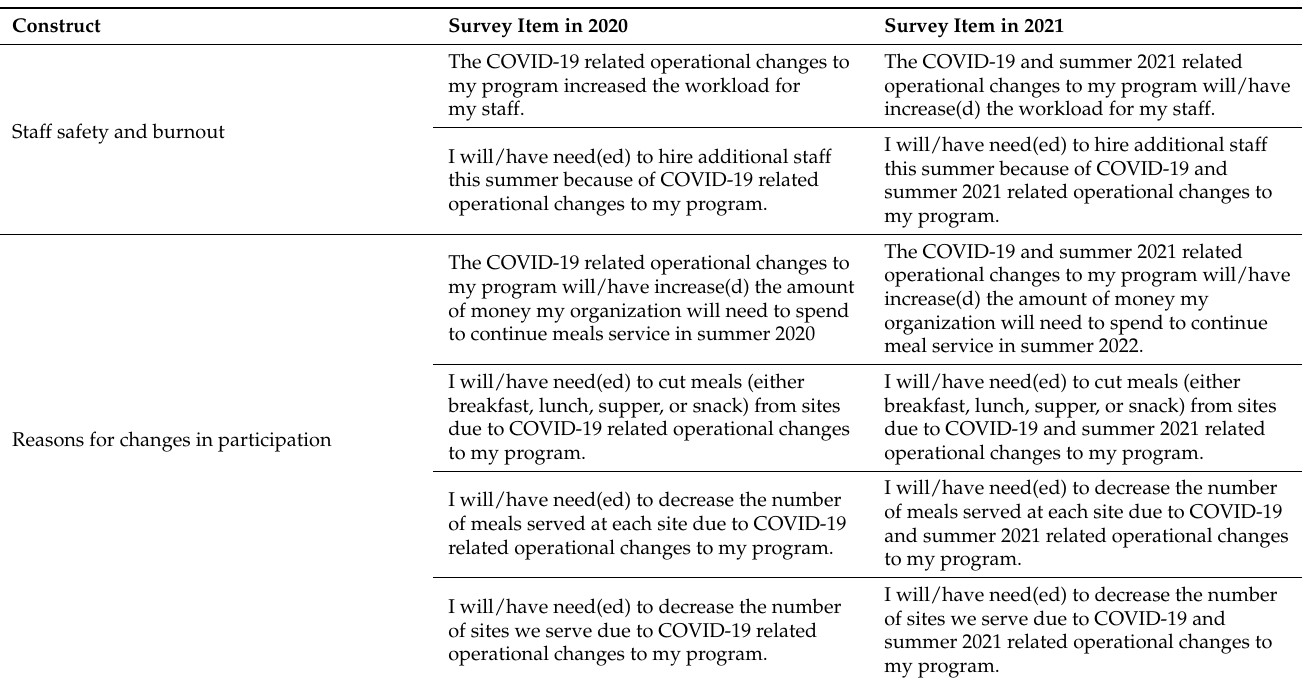
Table A1. 2020 and 2021 survey items regarding the perceived impact of the COVID-19 pandemic on operations.